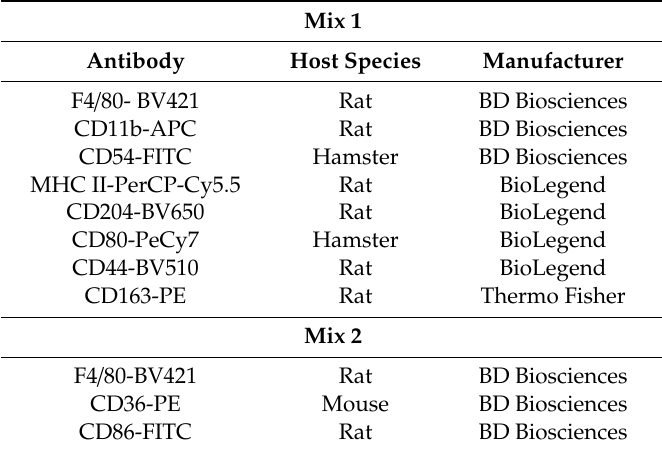
Table 2. Mixes of antibodies conjugated with fluorochromes used in the cytometric